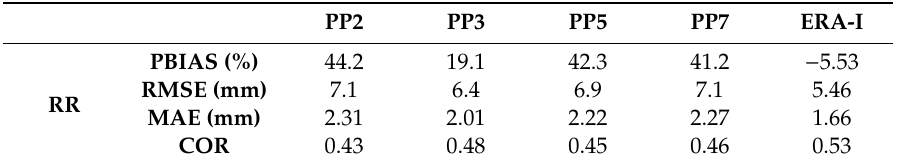
Table 4. Precipitation Statistical metrics of the four simulations for all stations daily precipitation (RR) for 2000–2004, over the area of